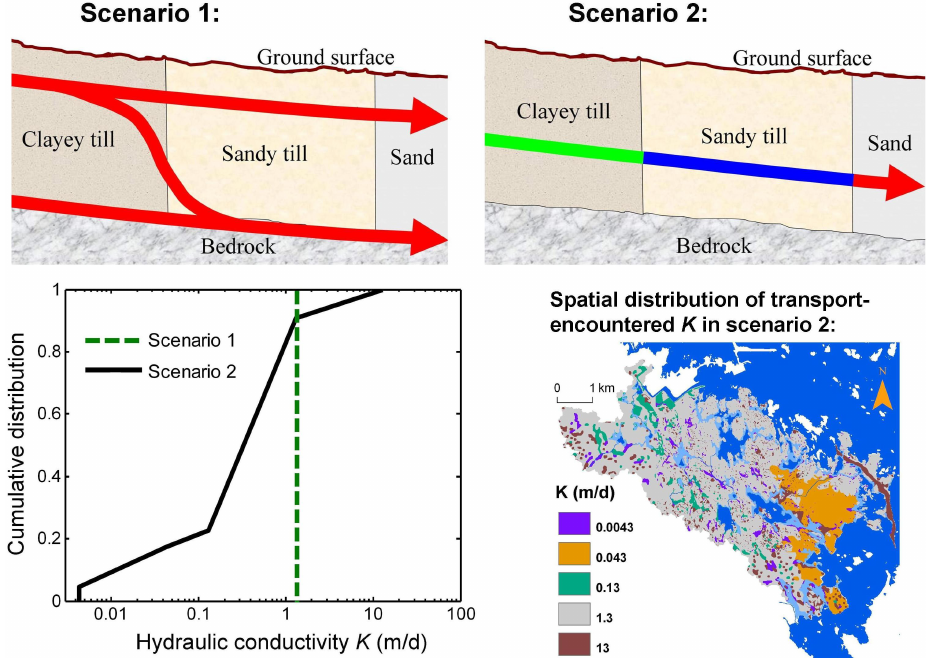
Fig. 1. Two scenarios of variability in saturated hydraulic conductivity, K , as encountered by the main flow and transport pathways (up) and their resulting cumulative K distribution (down left) in the Forsmark catchment (map, down right). Different arrow colours represent different transport velocities. Scenario 1 (constant K) represents transport that occurs predominantly in high-conductivity aquifer zones, such as near the soil surface, at the soil-bedrock interface, and/or other inter-connected preferential flow paths. Scenario 2 (spatially variable K) represents transport through soil and aquifer zones where K varies spatially according to the available information of soil cover and average permeability of each soil